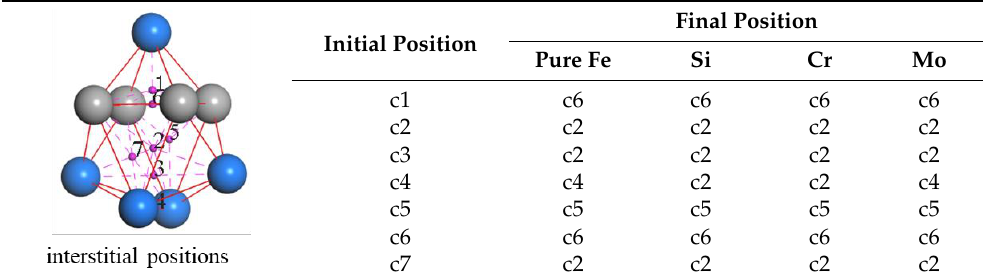
Table 1. Initial and final positions of the O atom in the CTP polyhedron unit of different alloyed Fe grain boundaries. All the interstitial positions for O atoms in the CTP unit with high symmetry are labeled by c1, c2, c3…c7.